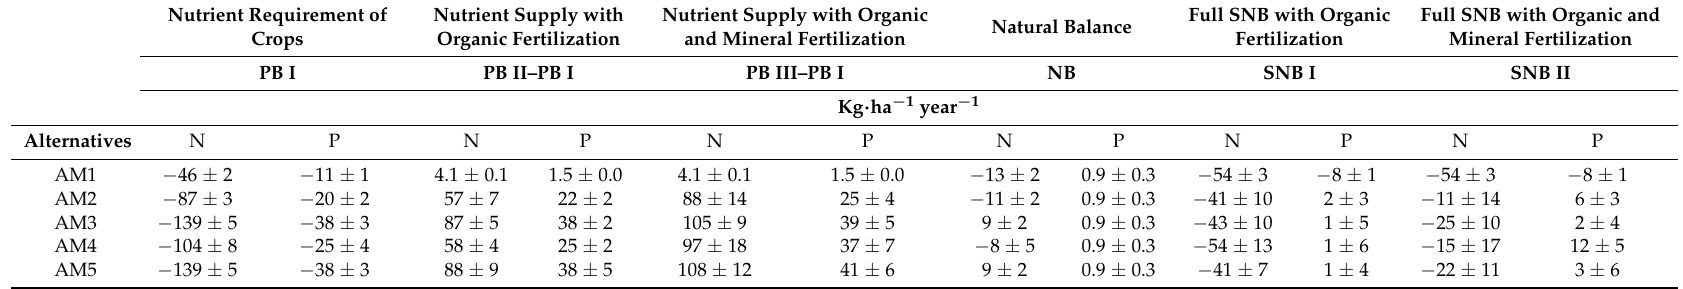
Table 4. Results of the SNB for intercropping of annual crops (maize, beans, cabbage and onion), on msiri land sized 0.125 ha located in Karagwe, TZ. Nutrient Requirement of Nutrient Supply with Crops Organic